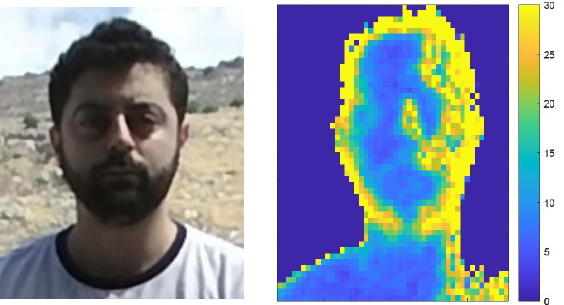
Figure 12. RGB image of a subject in sunlight ( left ), and corresponding depth noise image ( right ). Greater noise can be seen on the right side of the face indicating the sun’s direction.